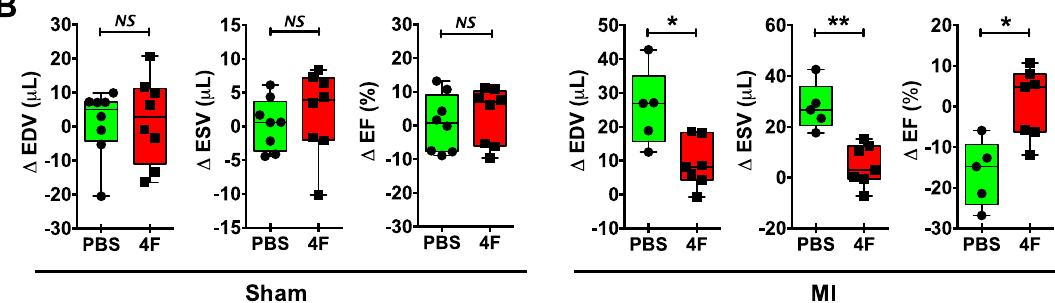
Figure 1. L-4F attenuates left ventricular (LV) remodeling after reperfused myocardial infarction (MI). ( A ) Representative long axis B-Mode echocardiographic images at end-diastole and the corresponding group data. Serial images were acquired at 3- and 8-day post ischemia / reperfusion. Mice were either injected with PBS or 100 µ g / day L-4F for 5 days starting at 3-day post-MI. The dotted line marks the LV cavity. ( B ) Echocardiographic group data depicting changes ( ∆ ) in end-diastolic and end-systolic volume (EDV and ESV) and ejection fraction (EF) from 3- to 8-days post-MI or sham operation with treatment with either PBS or L-4F as in ( A ) n = 6–8 / group, * p < 0.05, ** p < 0.005. NS – not significant.